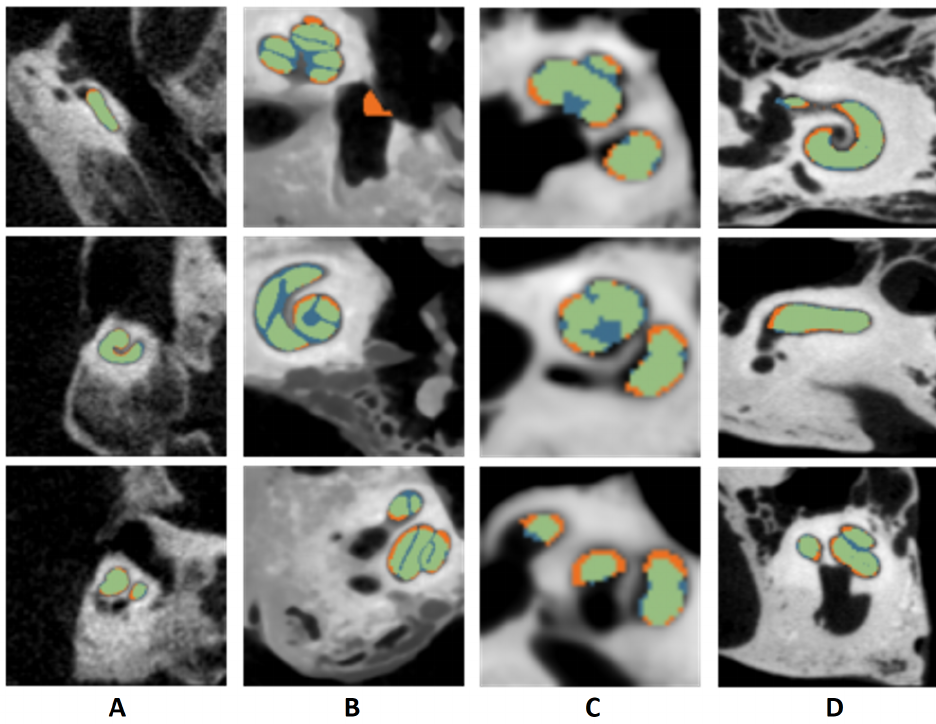
Figure 7. Segmentation output for different patients. ( A ) Clinical dataset, ( B ) cadaver dataset 1, ( C ) cadaver dataset 2, ( D ) cadaver dataset 3, blue: Nautilus estimation, orange: ground truth, green: overlap between the